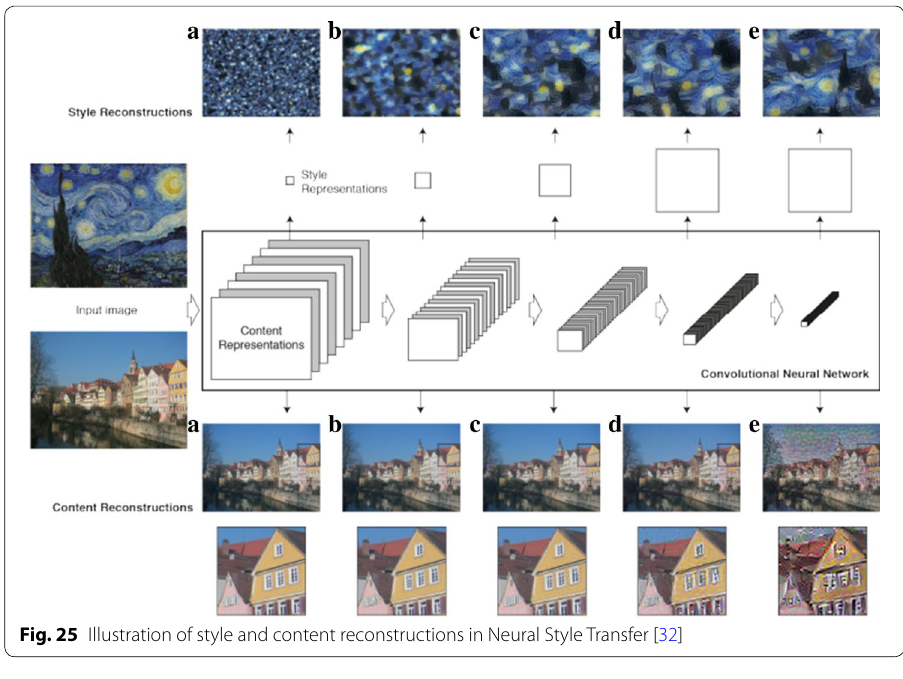
Fig. 25 Illustration of style and content reconstructions in Neural Style Transfer [32]